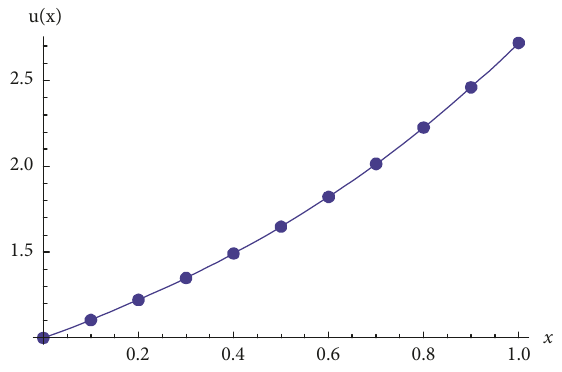
Figure 1: The exact and approximate solution for 𝑁 = 15 . Table 1: The error for Example